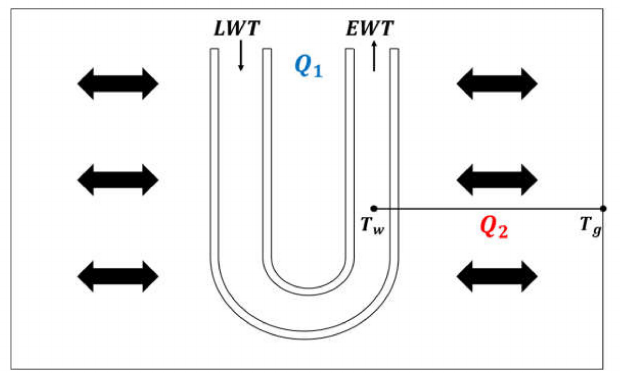
Figure 6. Concept of the heat transfer process under the ground